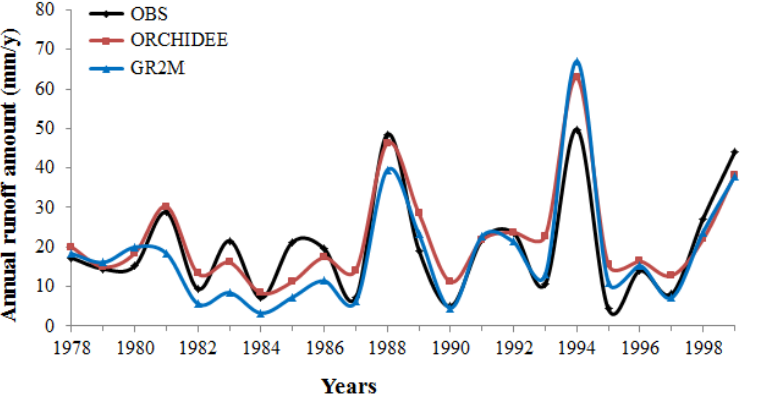
Figure 4. Monthly discharges at Wayen gauge from the observations and the simulations with GR2M during the 1978–1999 period. The green lines indicate the end of the period of calibration (December 1987) and the end of the validation period (December 1997).